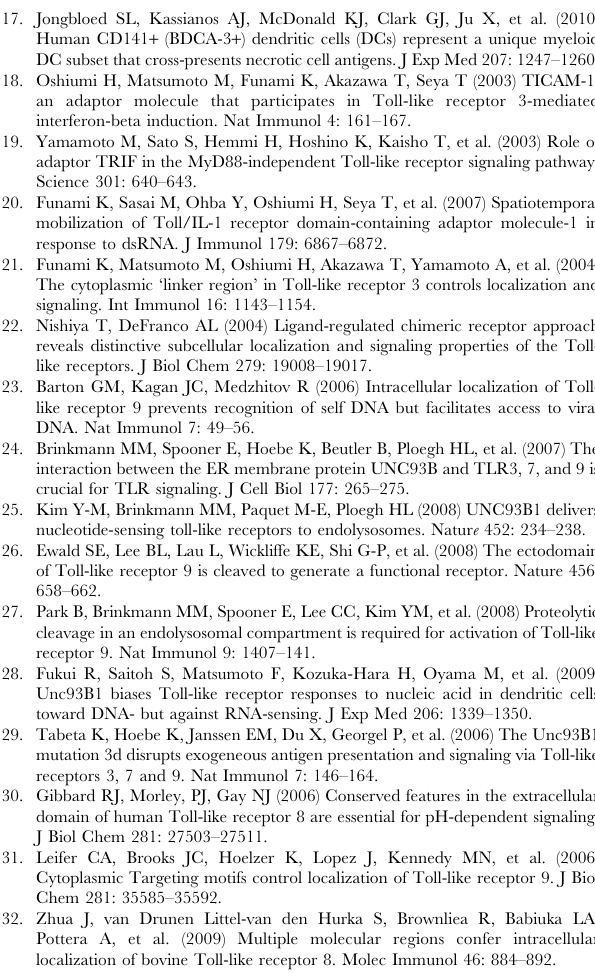
Figure S2 Forced expression of TLR8 mutants affects the endosomal localization of wild-type TLR8. A , Confocal images show HeLa cells co-expressing HA-tagged wild-type TLR8 and FLAG-tagged TLR8 mutants. Cells were fixed and stained with anti-FLAG mAb and anti-HA pAb, followed by Alexa568-labeled goat anti-mouse Ab and Alexa488-labeled goat anti-rabbit Ab. TLR8 mutants delCYT and delTIR were anchored on plasma membrane and did not merge with wild-type TLR8. Red,